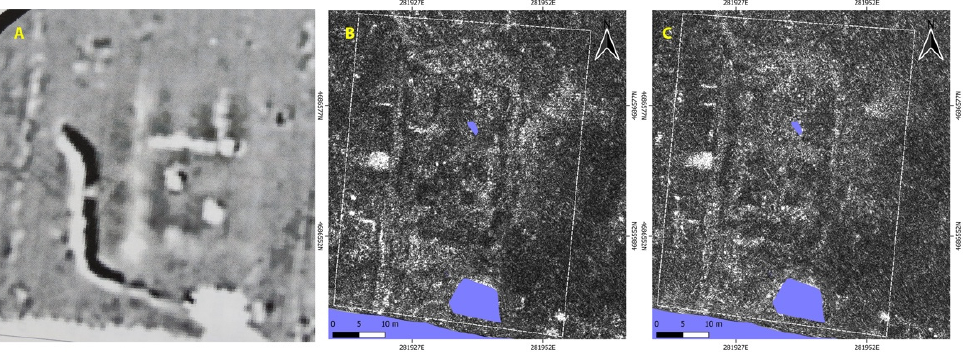
Figure 7. The “ Capitolium ” as detected by the magnetometer survey ( A ) and in the GPR time-slices with higher visibility: between 19–20 ns ( B ), and 22–23 ns ( C ) (from [28,34]; image by M. Serpetti).